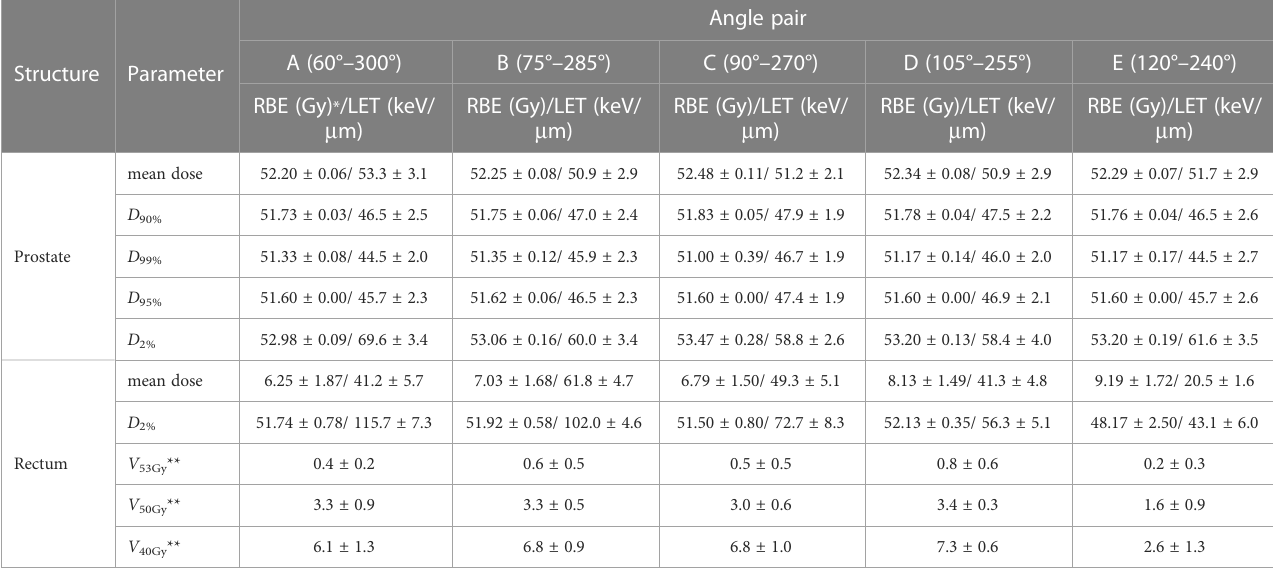
TABLE 2 Dosimetric parameters of the nominal plans using fi ve different angles pair conditions including conventional two opposite lateral fi elds (90° & 270°).